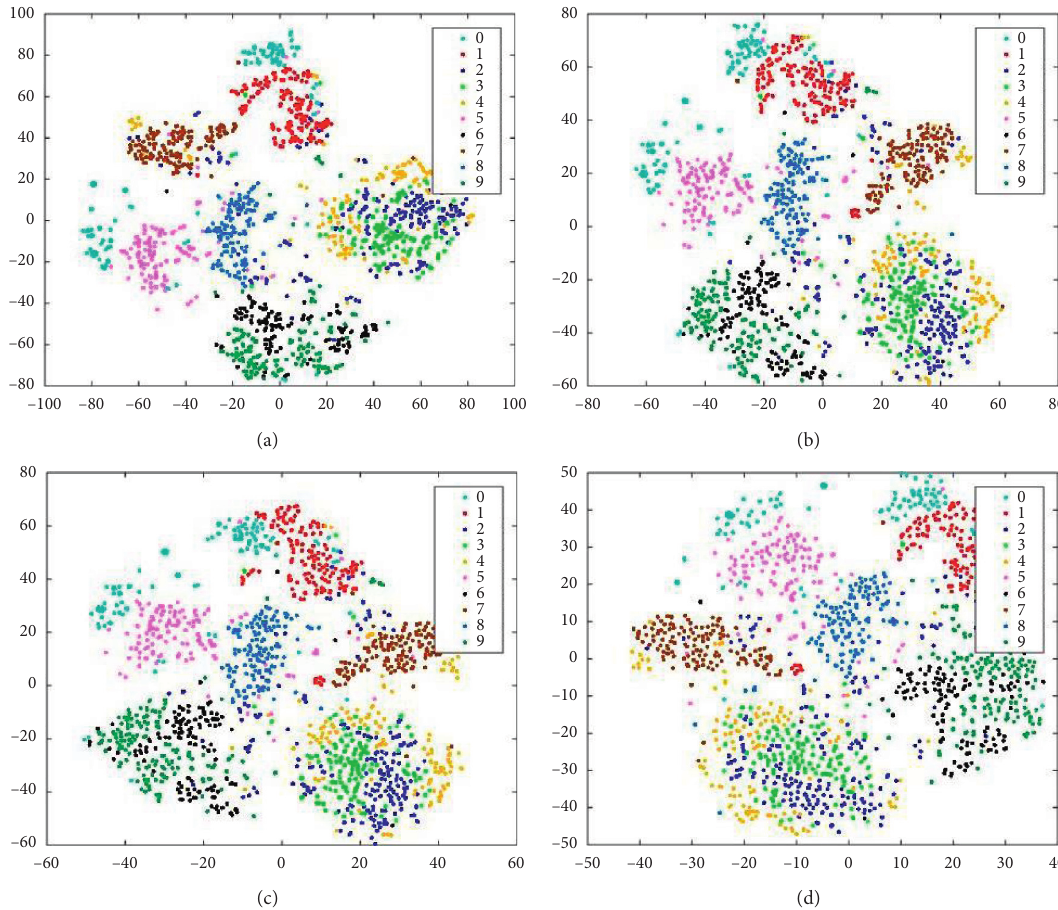
Figure 5: Standard t -SNE based visualization results of the data set containing pixel-based information only of the Urdu handwritten numerals. (a) Perplexity: 30 Iterations: 1,000. (b) Perplexity: 50 Iterations: 1,000. (c) Perplexity: 70 Iterations: 1 , 000. (d) Perplexity: 100 Iterations: